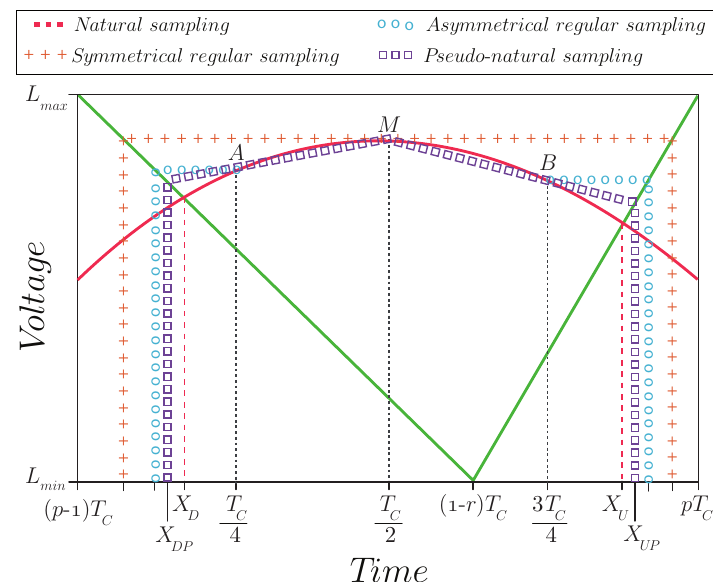
Figure 4. Sampling methods for a given switching interval: Comparison of natural, symmetrical regular, asymmetrical regular, and pseudo-natural sampling methods for